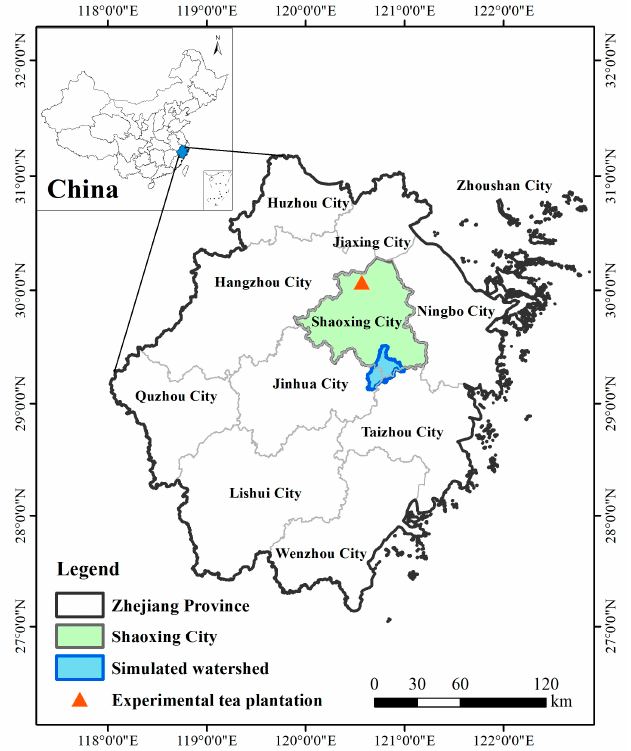
Figure 1. Location of the research site.